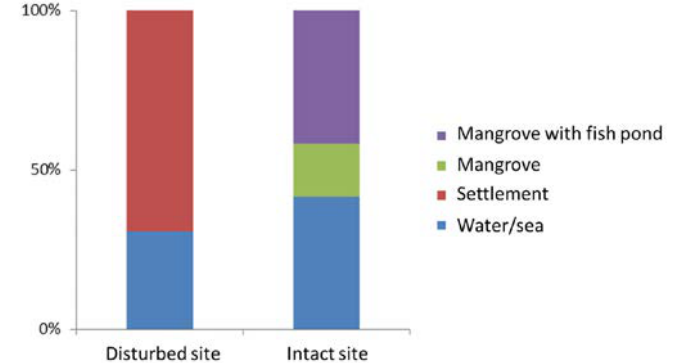
Fig. 3: Land-use compositions at disturbed and intact sites on West Java coast Fig. 3: Land‐use compositions at disturbed and intact sites on West Java coast Table 1: Summary of the mean and 95% CI and ANOVA for effects of disturbances on H’, DO, salinity, and pH at disturbed and intact sites Source of variations